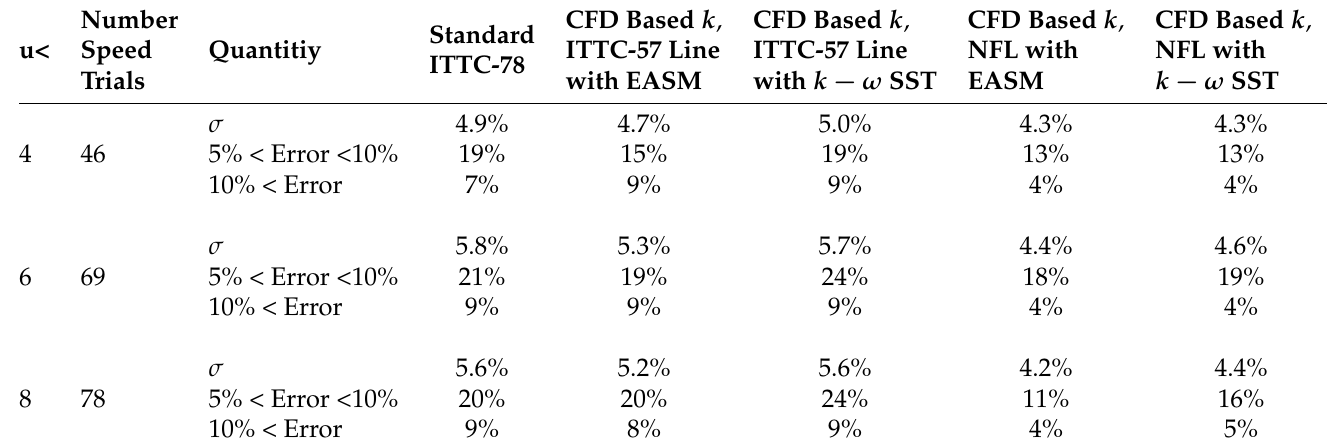
Table 3. Statistics of the power predictions compared to speed